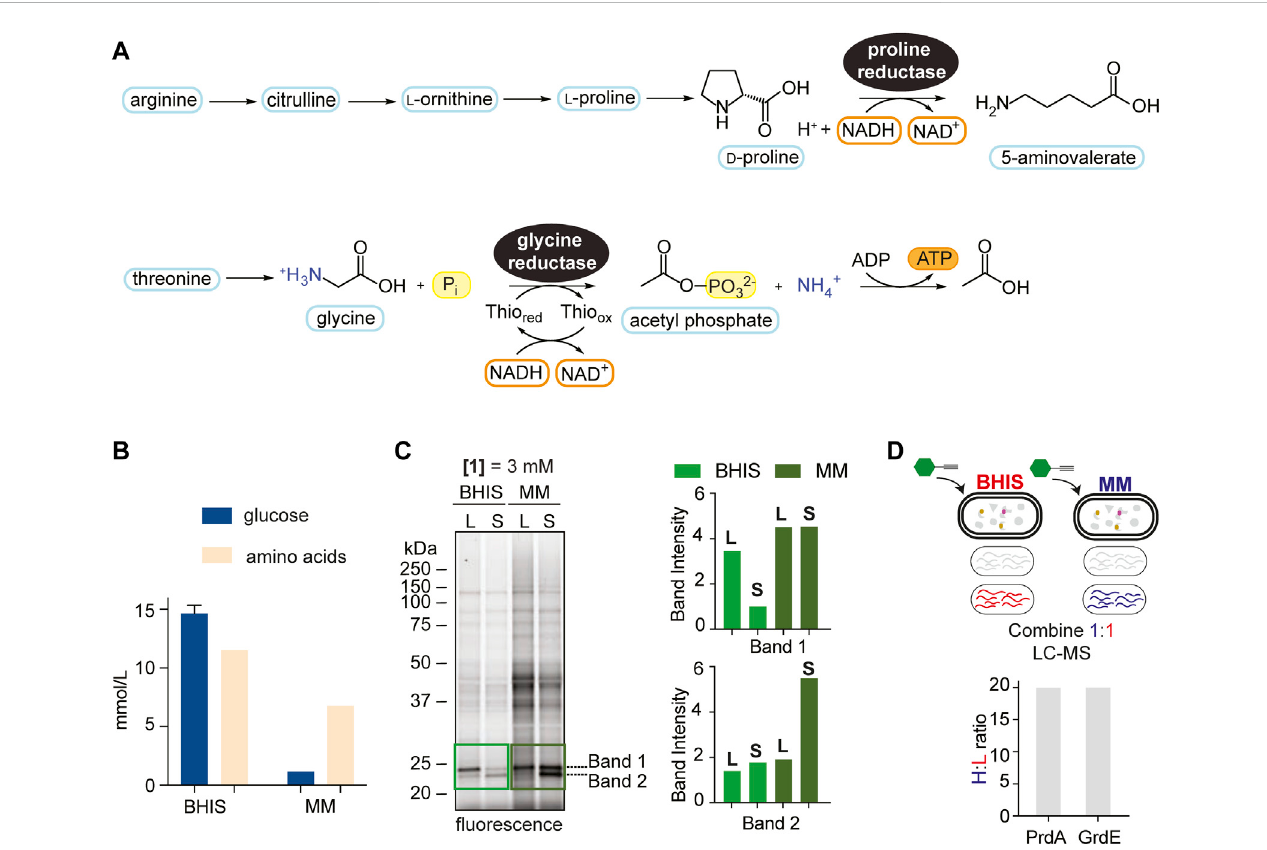
FIGURE 2 MediacomparisonshowingcontextdependenceofSticklandfermentation. (A) ,ThereductionofprolineandglycinebyPRandGR,respectively,through modi fi ed reductive Stickland pathways. (B) , Quanti fi ed amino acid and glucose concentrations (average of 3 technical replicates) (mmol/L) in BHIS and MM. SeeSupplementaryTablesS2,S3formoredetails. (C) ,Gel-basedlabellingpro fi lesofprobe 1 inthesolubleproteomeof C.dif fi cile cellscultivated inBHISand MMharvestedinmid-logphase(L)andstationaryphase(S)( left )andrelativebandintensitiesofBand1andBand2inthe20 – 25 kDaregionnormalizedto expression ( right ). Corresponding expression pro fi les are shown in Supplementary Figure S8. Intensity of Band 2 in BHIS is set to a relative intensity of 1. (D) , ComparisonofPrdAandGrdEenrichmentbyhydrazineinBHISandMMusinglate-stagereductivedimethylation.RatiosquantifyandcomparePrdAandGrdE activity in the different media environments. Averages from two technical replicates along with standard deviations are